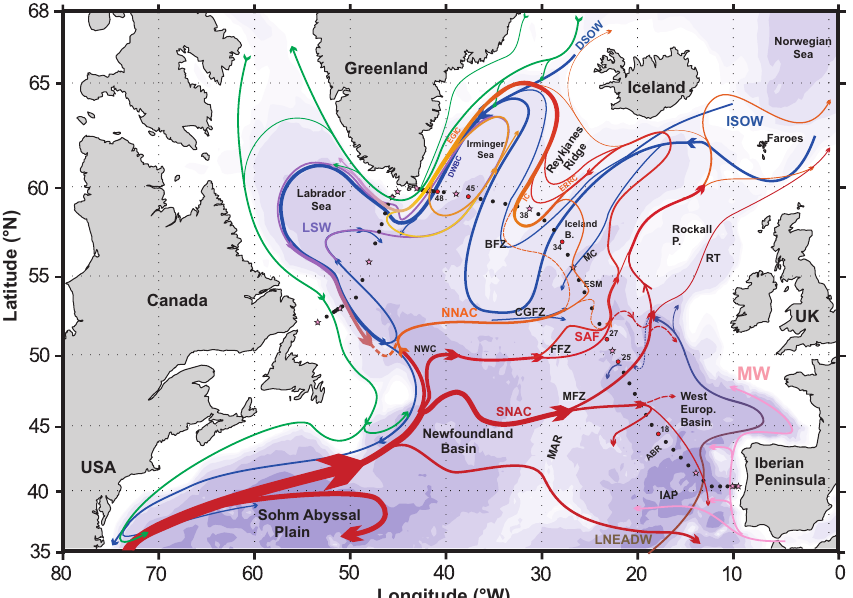
Figure 1. Schematic diagram of the 2002–2012 mean large-scale circulation adapted from Daniault et al. (2016). Bathymetry is plotted in color with color changes at 100 and 1000m and every 1000m below 1000m. The locations of the GEOVIDE hydrographic stations are indicated by black dots along the OVIDE section and across the Labrador Sea. Red dots and associated numbers along the OVIDE section show the stations delimiting the regions used in this paper for the transport computations of the different currents crossing the OVIDE section. The names of the main currents are indicated in the figure: East Greenland–Irminger Current (EGIC), Deep Western Boundary Current (DWBC), Irminger Current (IC), Eastern Reykjanes Ridge Current (ERRC), the northern branch of the North Atlantic Current (NNAC), Subarctic Front (SAF), and the southern branch of the North Atlantic Current (SNAC). Super stations and XL stations established during GEOVIDE are represented by pink stars. The main topographical features of the subpolar North Atlantic are labeled: Azores–Biscay Rise (ABR), Bight Fracture Zone (BFZ), Charlie–Gibbs Fracture Zone (CGFZ), Faraday Fracture Zone (FFZ), Maxwell Fracture Zone (MFZ), Mid-Atlantic Ridge (MAR), Iberian Abyssal Plain (IAP), Northwest Corner (NWC), Rockall Trough (RT), Rockall Plateau (Rockall P.), and Maury Channel (MC). The main water masses are indicated: Denmark Strait Overflow Water (DSOW), Iceland–Scotland Overflow Water (ISOW), Labrador Sea Water (LSW), Mediterranean Water (MW), and lower Northeast Atlantic Deep Water